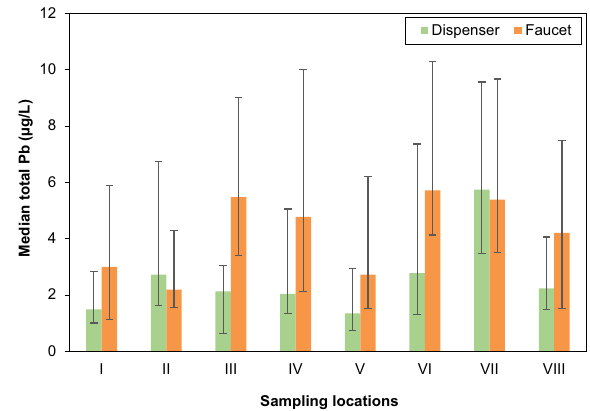
Fig. 2 Comparison of Pb concentration at different sampling locations. Median total Pb concentration in water samples collected from dispensers and faucets in various sampling buildings on a school campus. Error bars represent the values of the fi rst (Q1) and third (Q3)